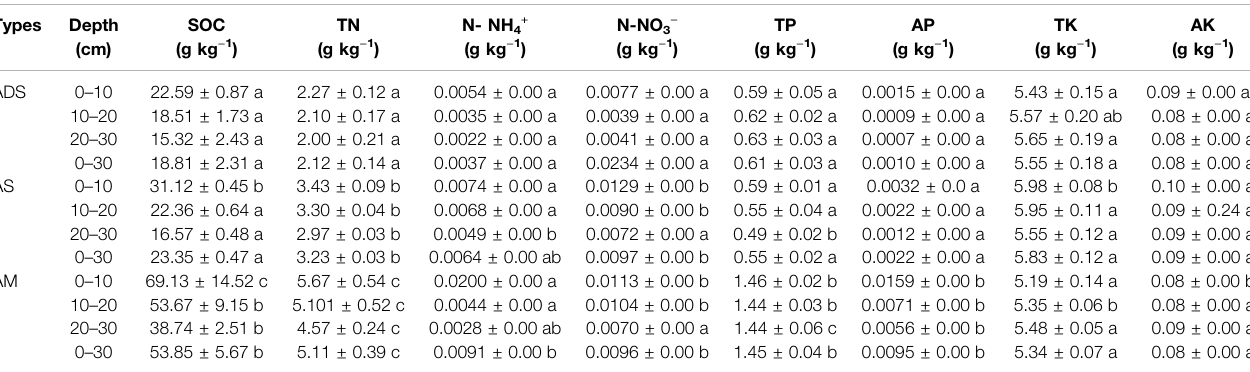
TABLE 4 | Chemical properties of soil under three vegetation